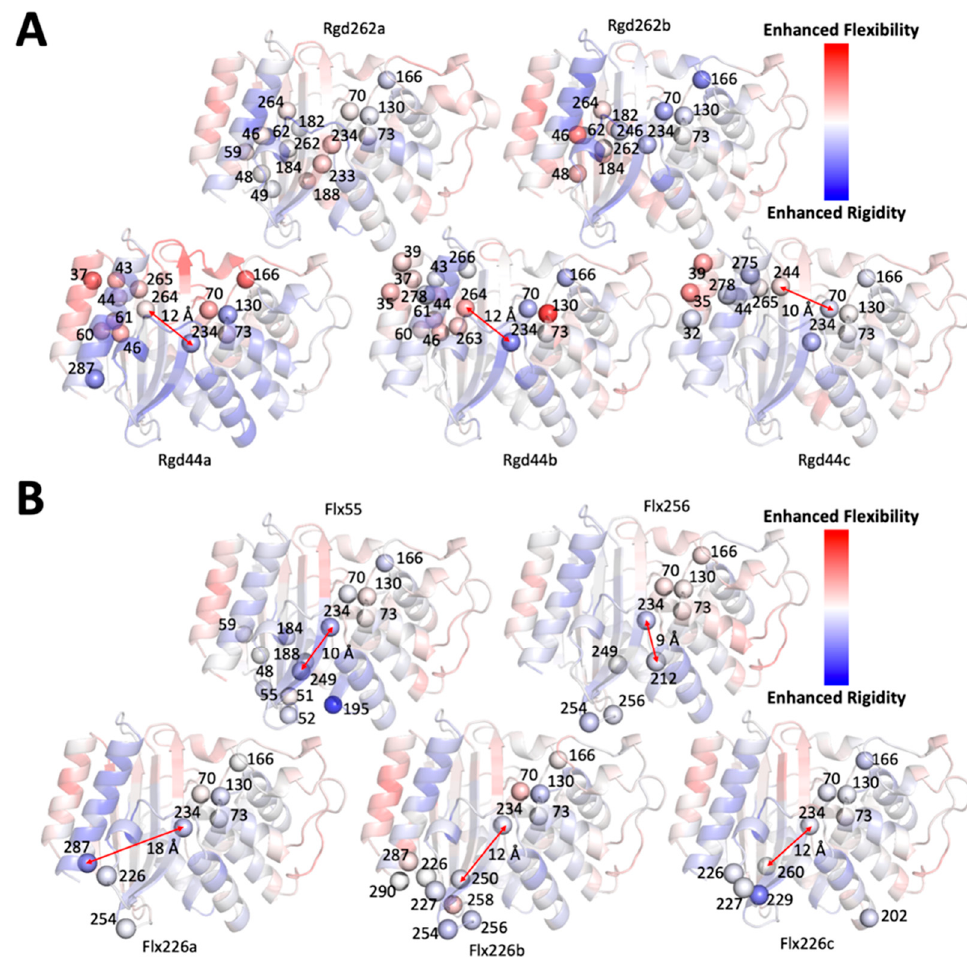
Figure 5. The change in the dynamics profiles of experimentally characterized rigid ( A ) and flexible ( B ) designs ( ∆ dfi values) are mapped onto the TEM-1 structure. Point mutations around the residues targeted for design and the catalytic residues in TEM-1 are shown as spheres and labeled with their residue indices. The distance between the mutations closest to the catalytic residues are marked with red arrows and labeled with the corresponding distance in angstroms. The minimum distance in most designs is larger than 10 Å (Rgd262a and b and Flx256 are exceptions), which suggests that the changes in dynamics of catalytic residues is due to distal allosteric communication with the active site in many